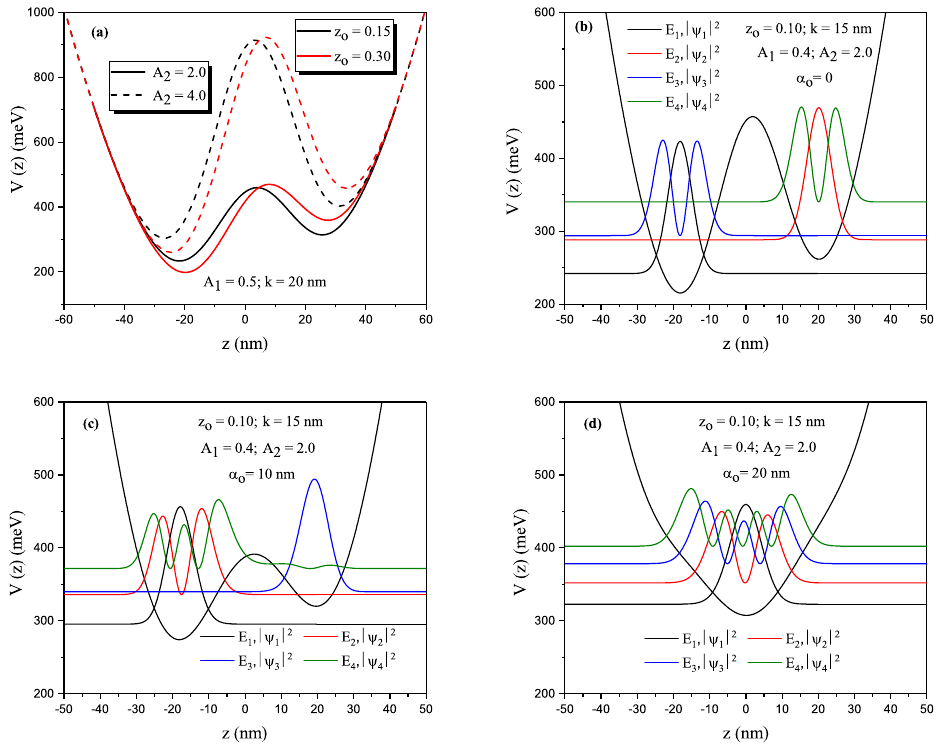
Figure 2. ( a ) Parabolic–Gaussian asymmetric DQW confinement profiles for the parameters of k = 20nm, A 1 = 0.5, A 2 = 2.0 (solid curves) and A 2 = 4.0 (dashed curves) and for two different z o values, black (red) curve is for z o = 0.15 ( z o = 0.30 ) , parabolic–Gaussian asymmetric DQW potential and squared modulus of the wave functions corresponding to the first four energy levels for ( b ) α o = 0 , ( c ) α o = 10nm, and ( d ) α o = 20nm. The results in Figure 2b–d are for z o = 0.10, k = 15nm, A 1 = 0.4, A 2 =